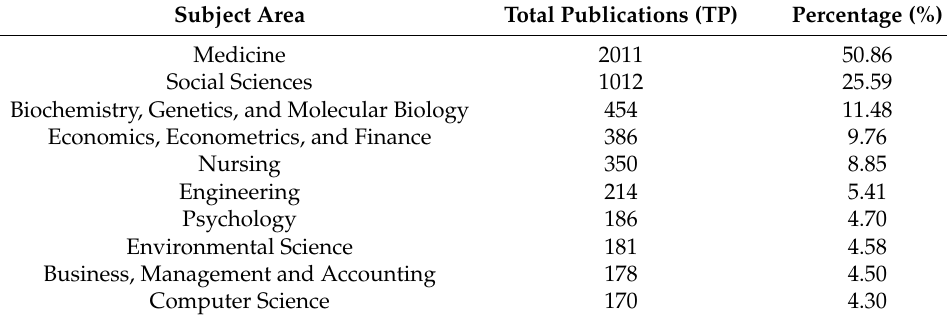
Table 2. Top ten subject areas.